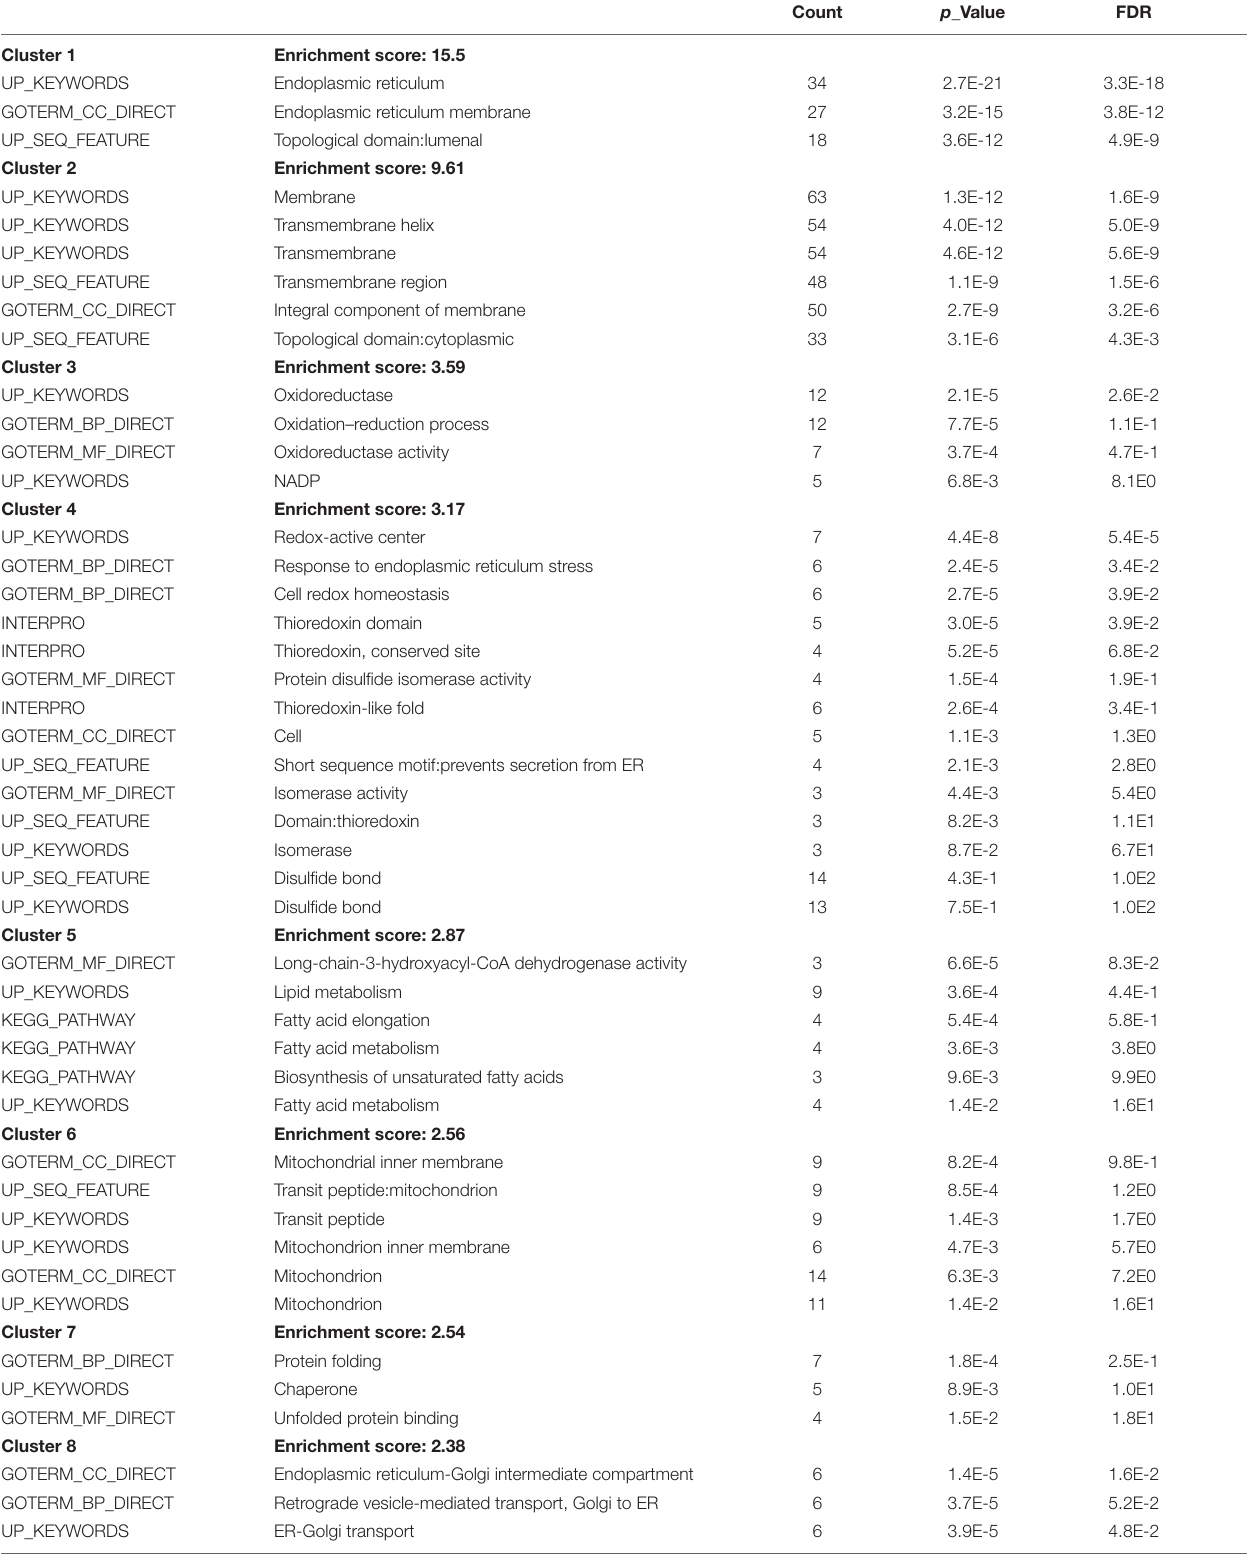
TABLE 4 | Gene ontology (GO) functional annotation